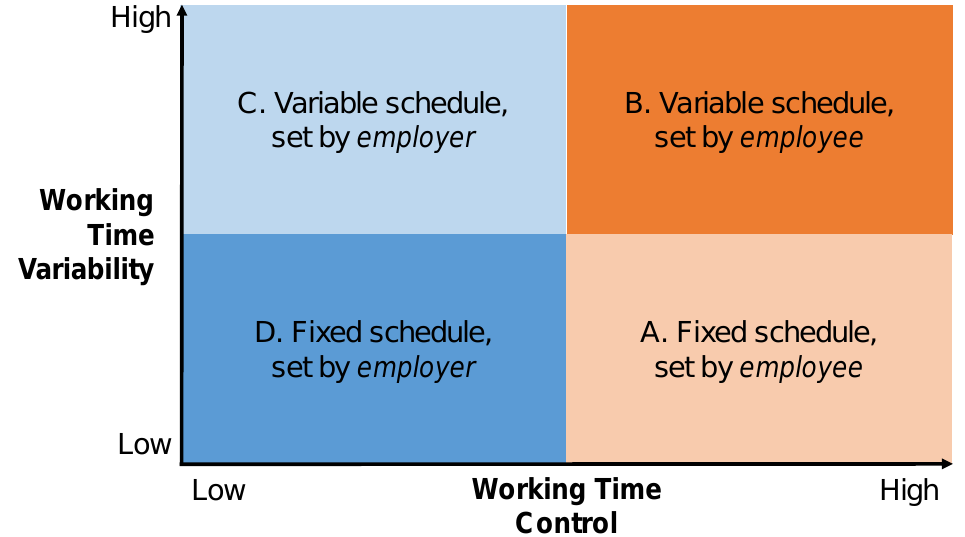
Figure 1. Four types (A.–D.) of working time control and working time variability adapted from [51]. Research shows that WTC can buffer the adverse effects of working time demands